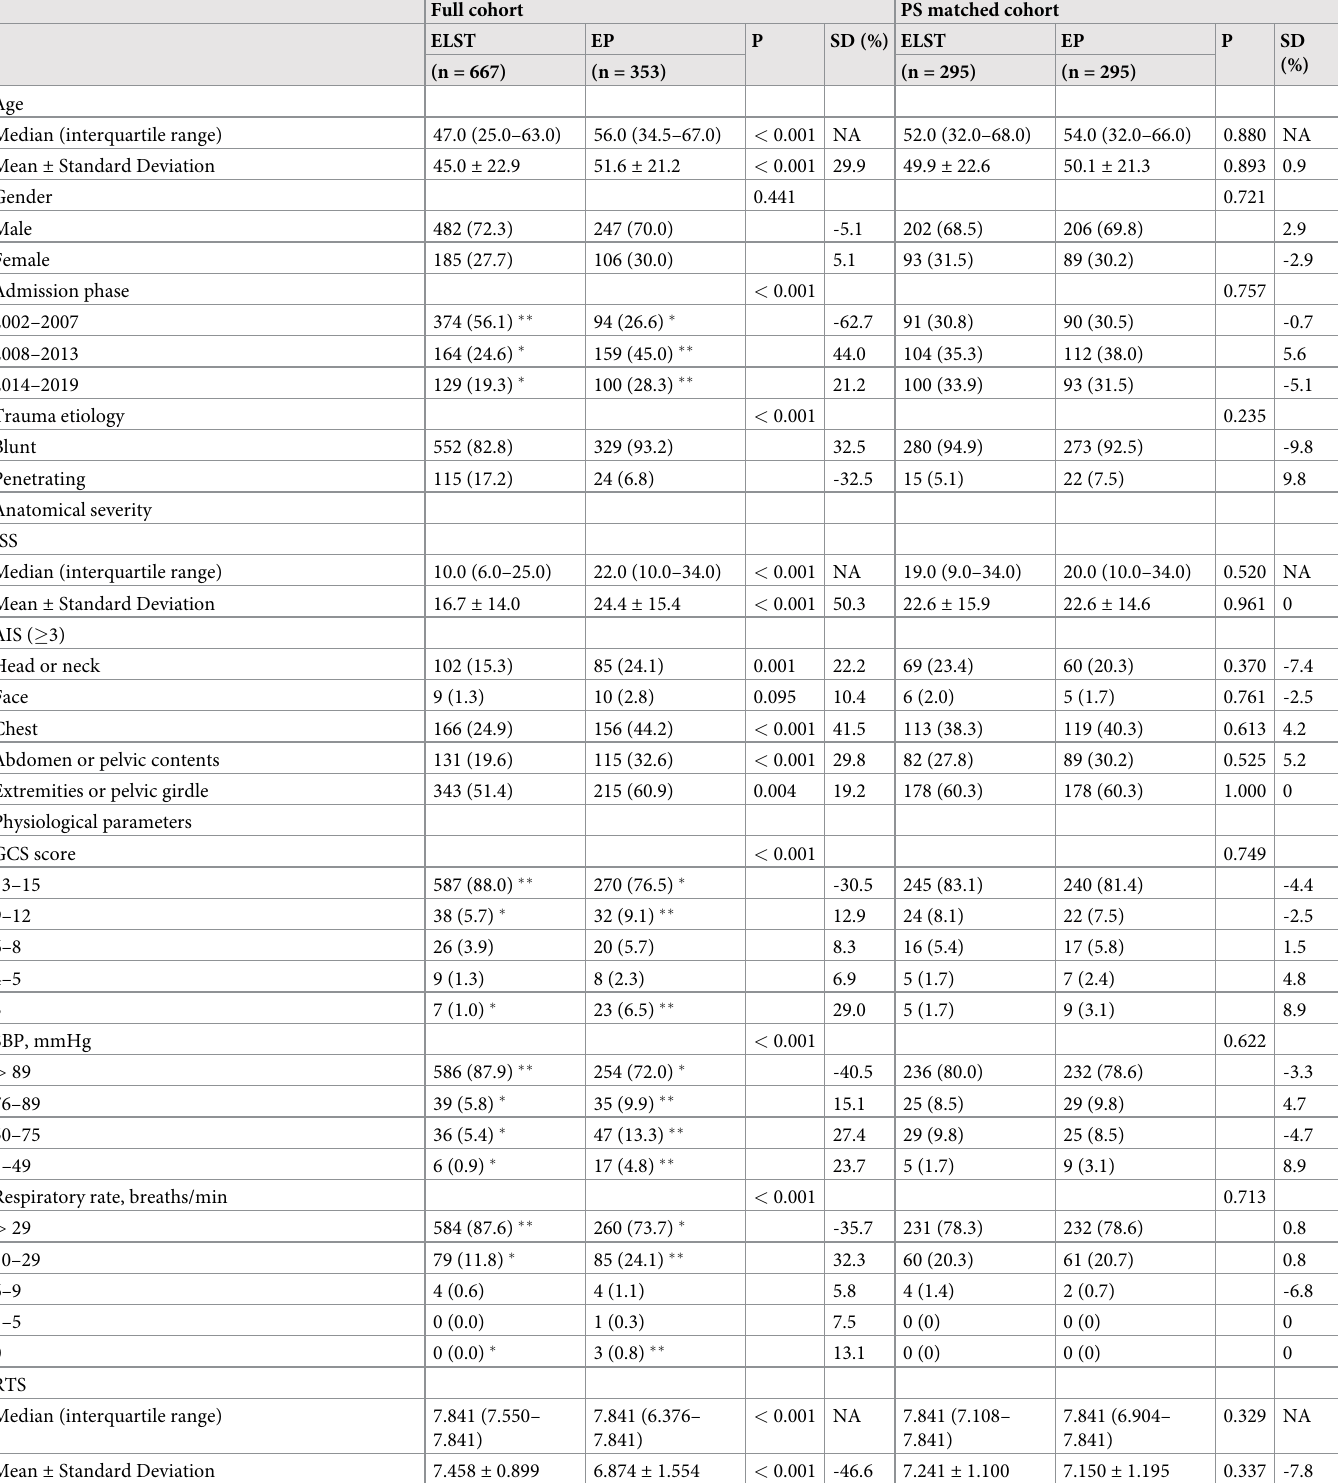
Table 1. Demographic and clinical characteristics of injured patients requiring emergency surgery or transcatheter arterial